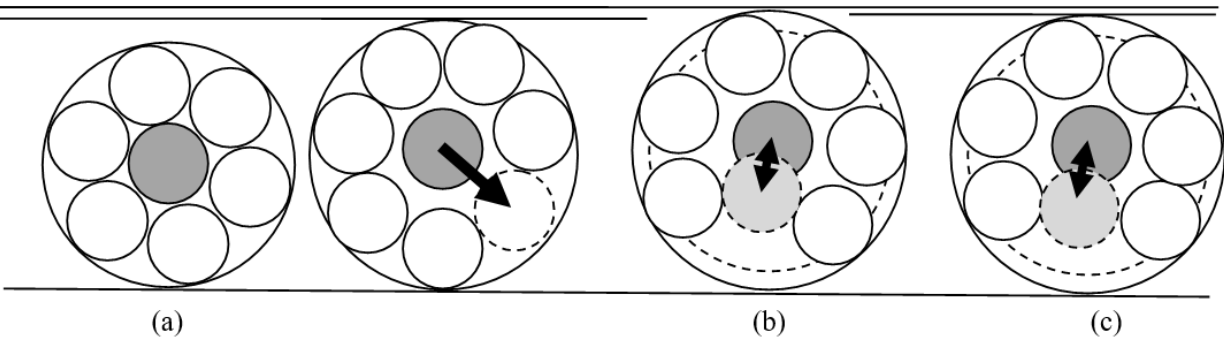
Figure 2. Geometrical approach to shifting possibilities. In case ( a ) of Figure 2, all spheres first swing radially at the same time and then crowd together along the boundary. This scenario seems extremely unlikely, if not impossible. Scenario ( b ) seems to be more realistic and raises the question as to what minimum distance the limit must be in order for at a certain moment a gap to open and the middle sphere to move out of its position. Presumably the situation ( c ), as an intermediate between ( a ) and ( b ), comes closest to the truth.